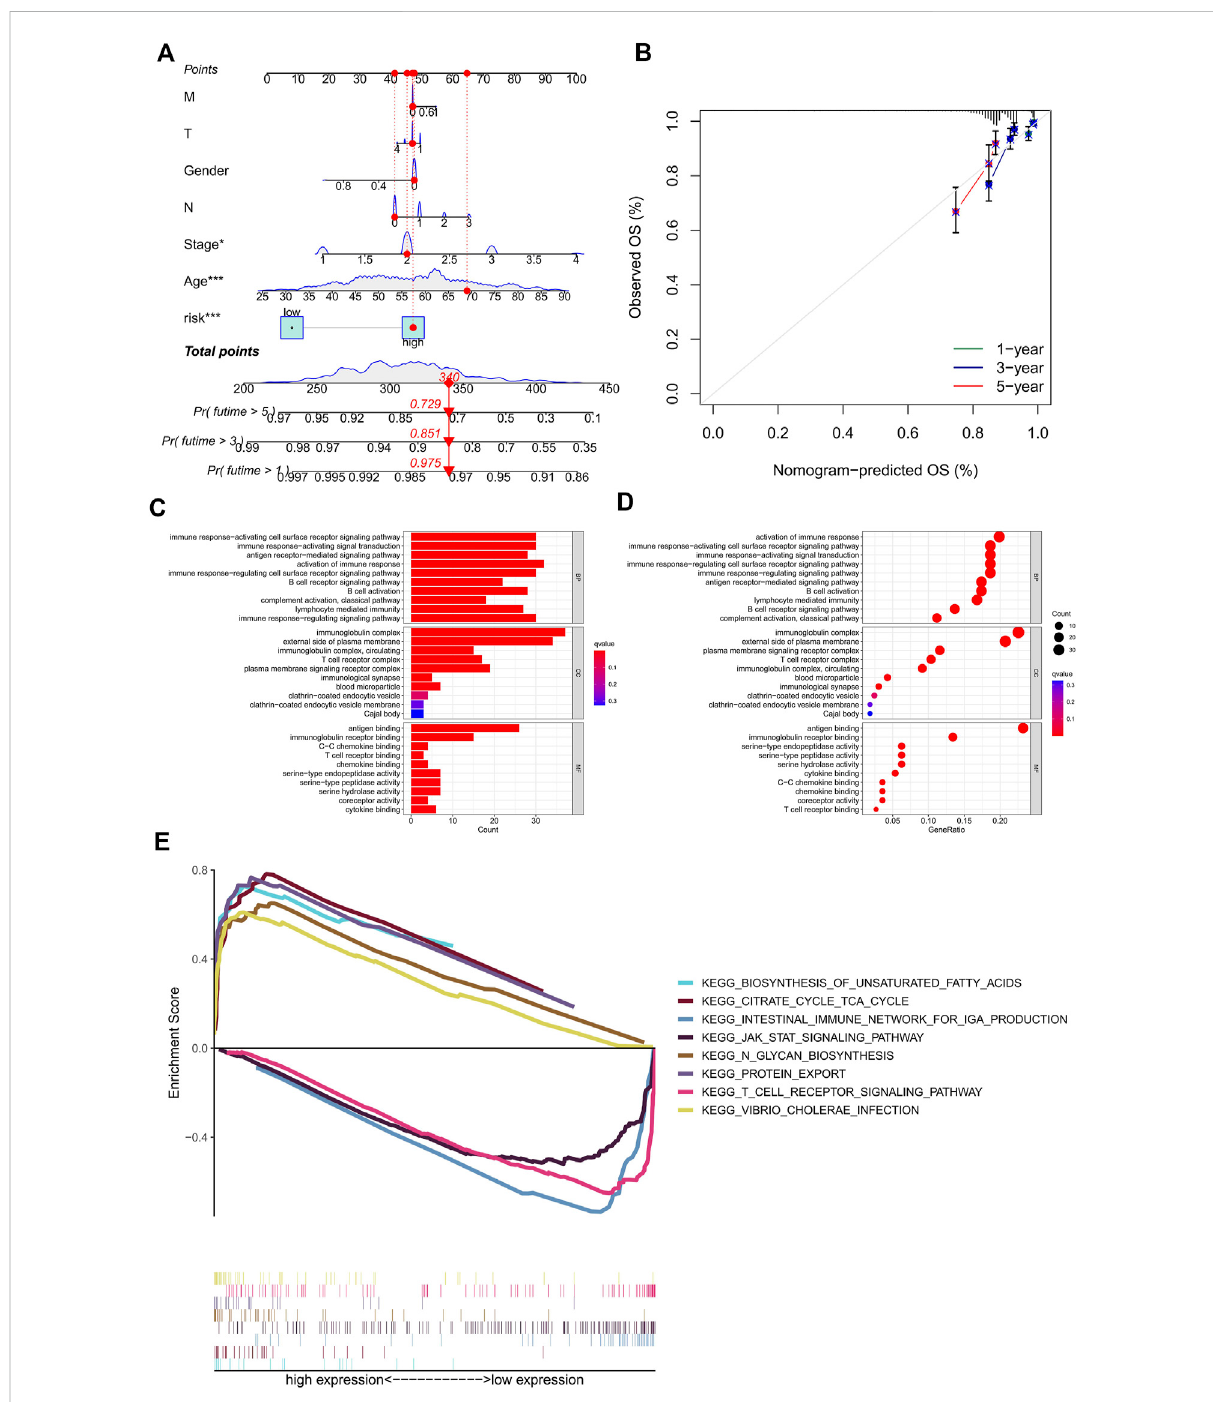
FIGURE 4 Constructionofthenomogramand calibration curves,enrichmentanalysis of theprognostic signature. (A) nomogramprediction model ofthe combined risk score and clinicopathological characteristics for 1-, 3-, and 5-year OS rate in BC patients. (B) Calibration curves for the relationship between predicted survival and the observed OS rate at 1, 3, and 5 years (C – D) The GO function enrichment analyses. (E) The GSEA pathway enrichment analyses. OS, overall survival; BC, breast